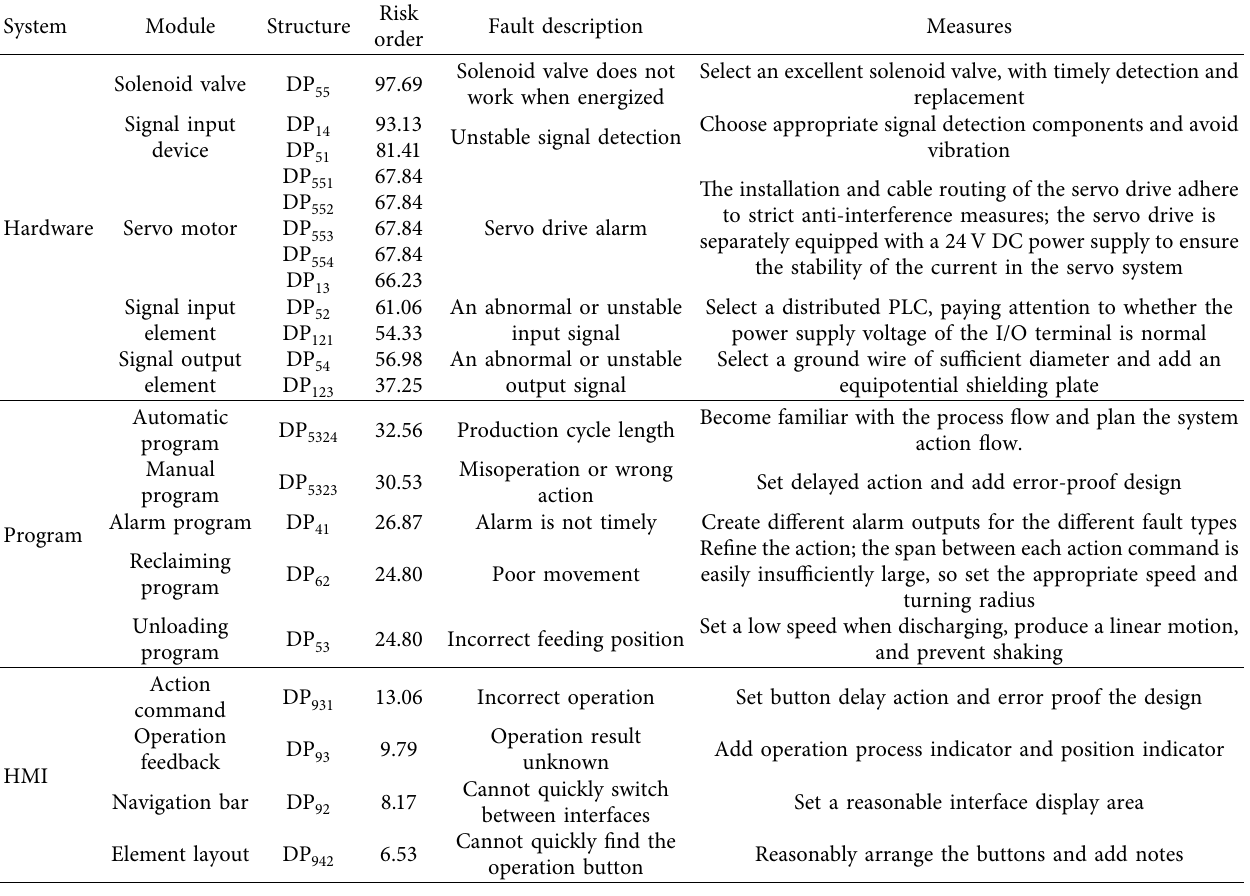
Table 14: Analysis of the potential failure risk of the control service system.